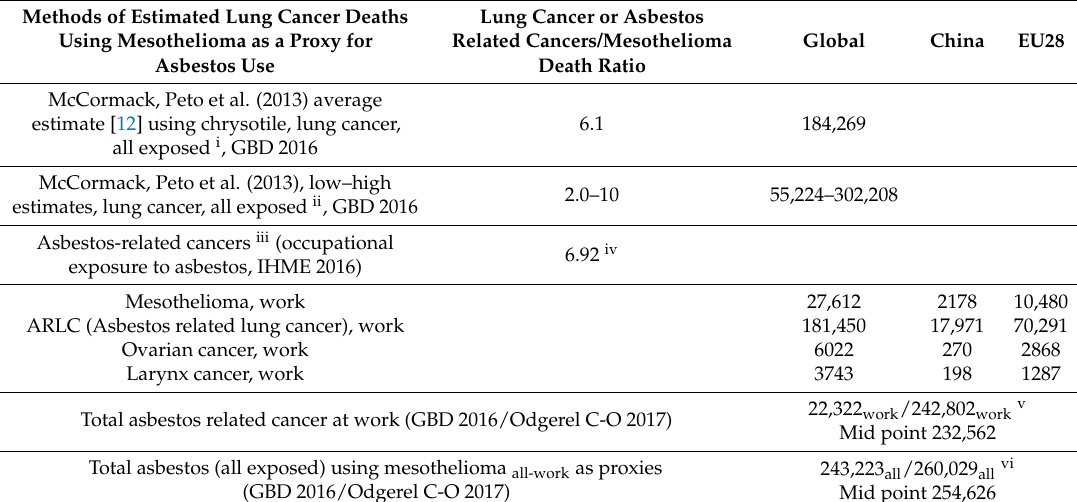
Table 2. Asbestos-related lung cancer and other asbestos-related deaths.